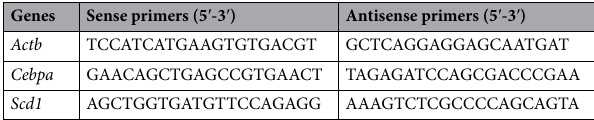
Table 2. Primers for real-time